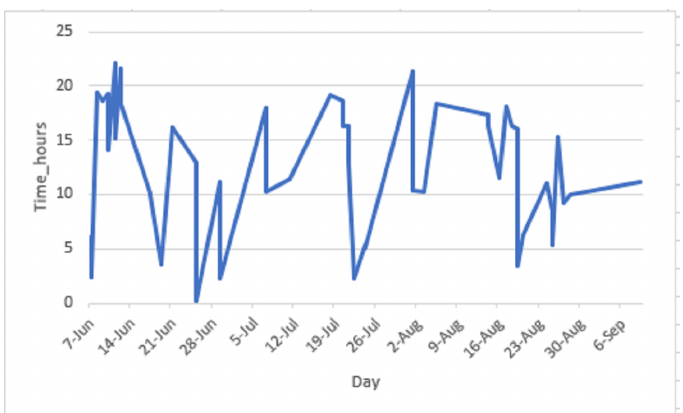
Figure 16. Crater visiting time.